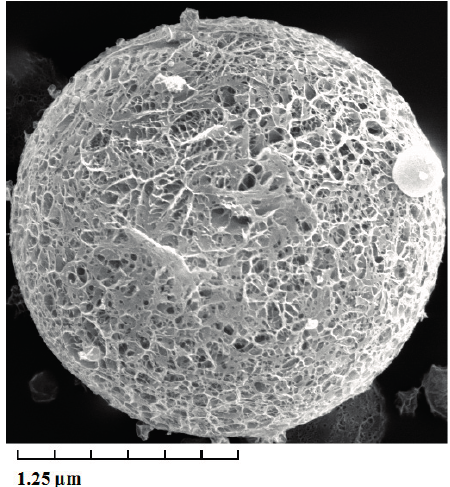
Figure 1. Transmission electron microscope photograph of lidocaine-loaded